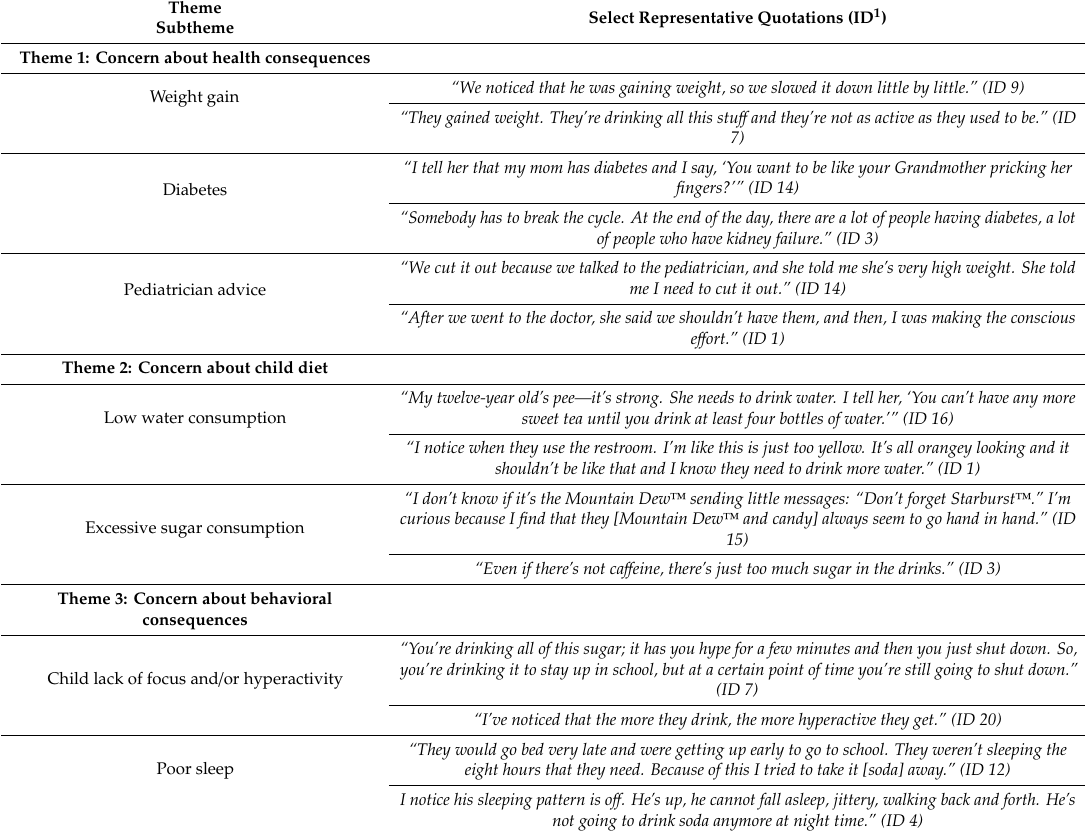
Table 2. Parents’ Concerns about Child Ca ff einated Sugar-Sweetened Beverage (CSSB) Intake. Theme Subtheme